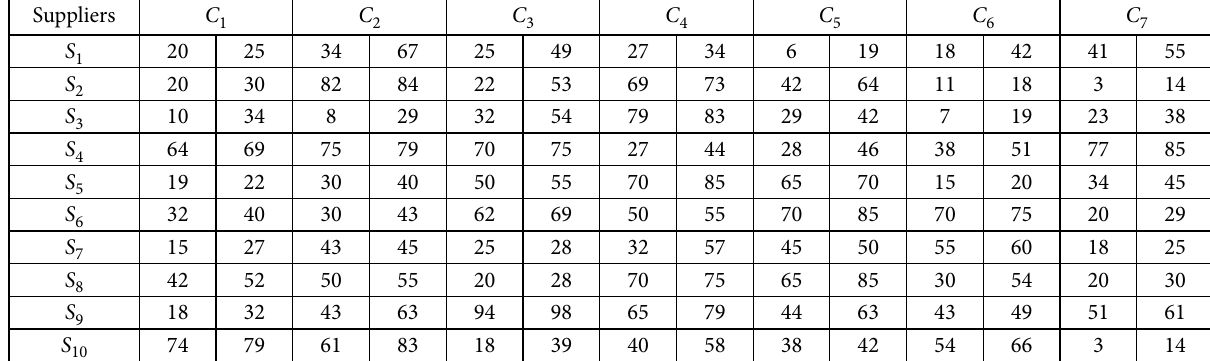
Table 8. The grey measurement of supplier performance (Expert